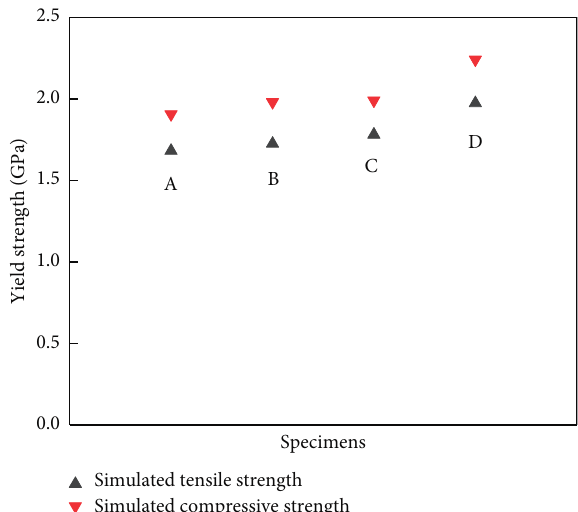
Figure 10: Comparison on the yield strength between tension and compression. It is found that compressive yield strengths are uniformly higher than ones under tension because of hydrostatic stress